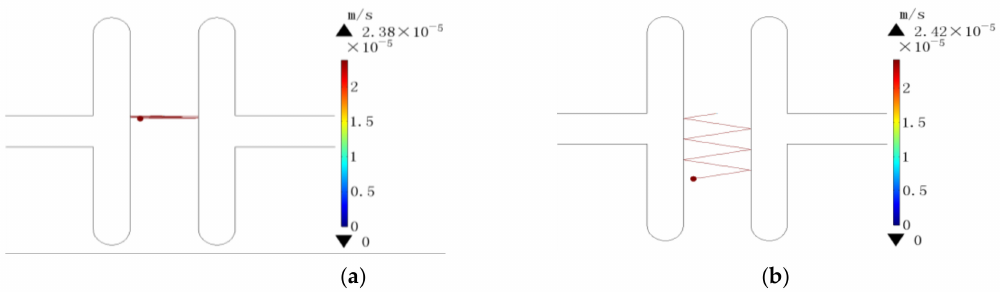
Figure 5. Motion simulation of cellulose and copper particles in mineral oil under DC electric field.